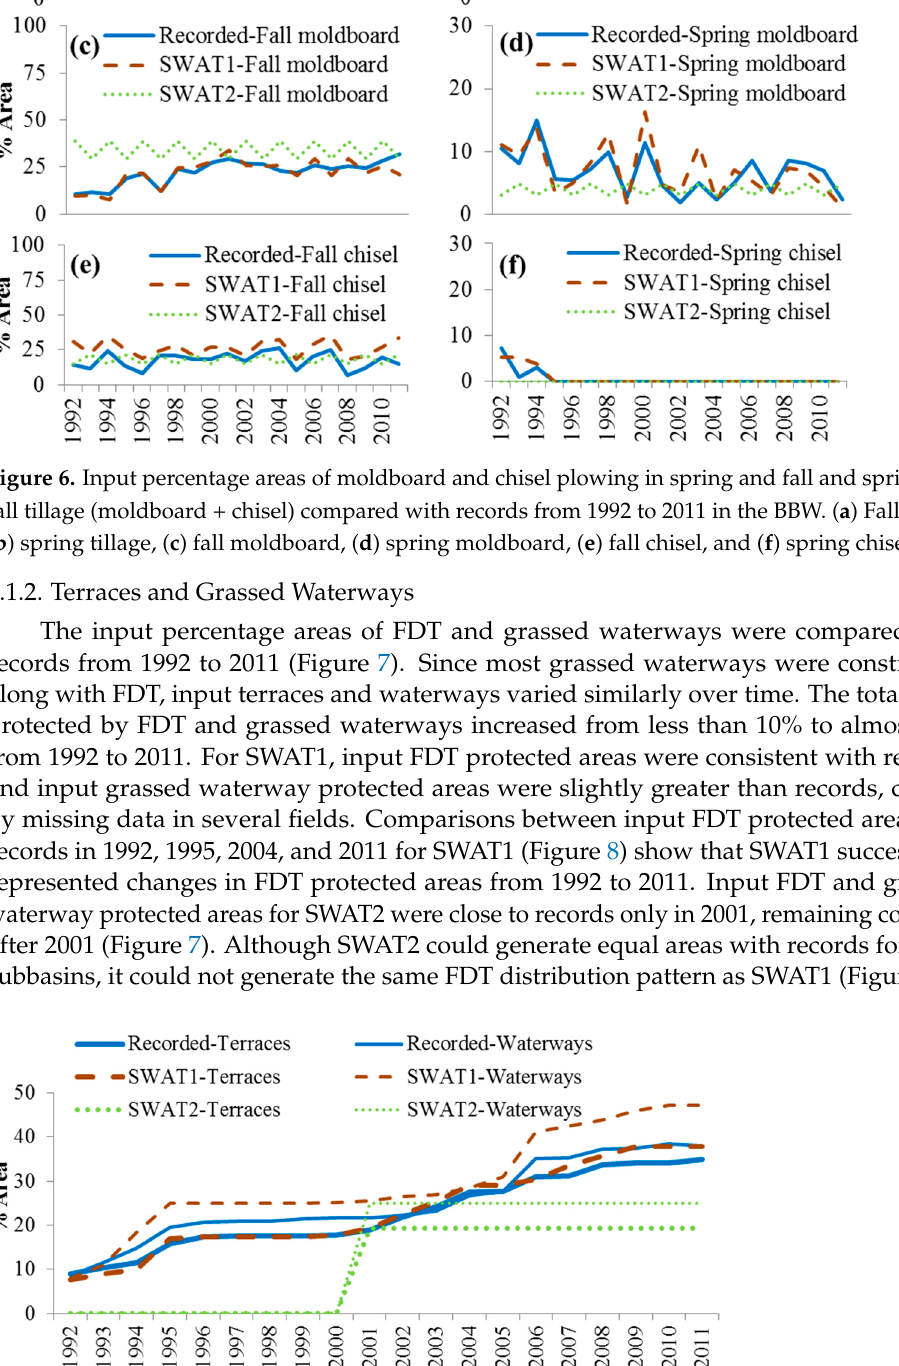
Figure 8. Recorded (top panels) and input (bottom panels) FDT protected areas in the BBW for ( a1 versus a2 ) 1992, ( b1 versus b2 ) 1995, ( c1 versus c2 ) 2004, and ( d1 versus d2 ) 2011. Results are from the SWAT1 model.